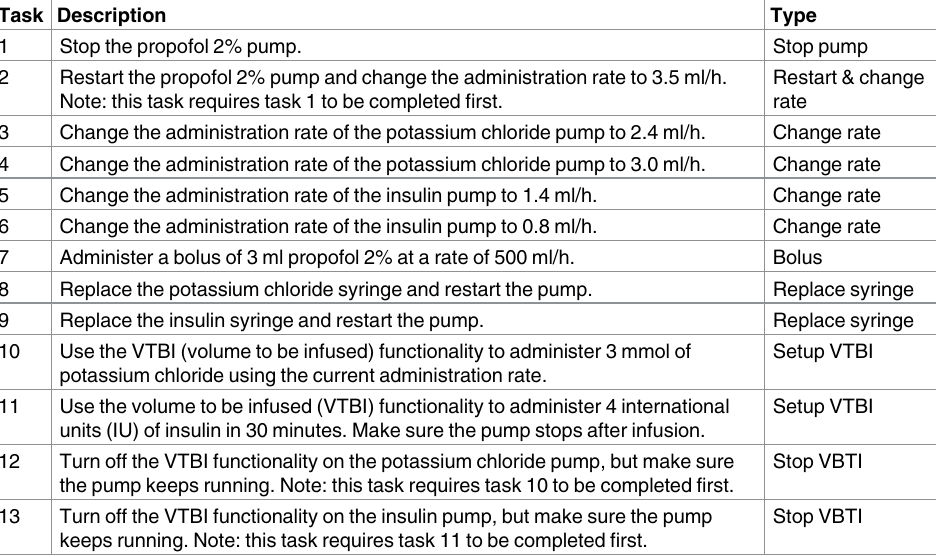
Table 1. Description of experimental assignments. Task